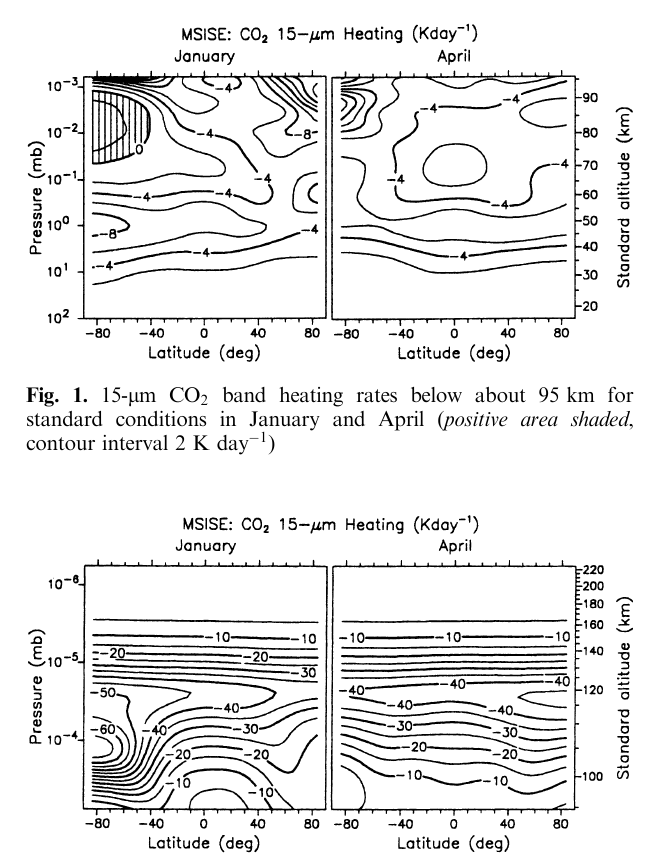
Fig. 2. Same as in Fig. 1 but above 95 km (contour interval 5 Kday (cid:255) 1 )